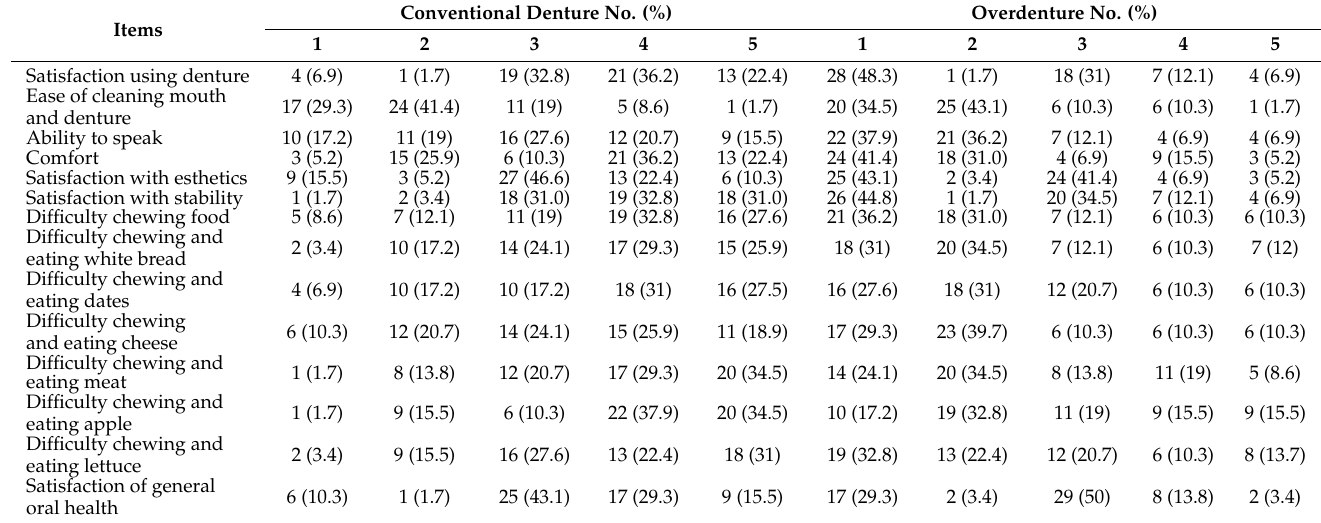
Table 2. Distribution of satisfaction level responses towards using conventional implant dentures and implant overdentures ( n =